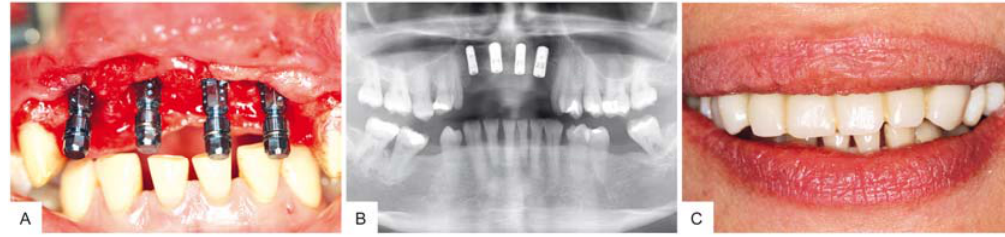
Figure 4. Four implants were placed in locations #7, #8, #9 and #10. ( A ) Buccal view after implant placement; ( B ) Radiograph taken immediate after the procedure; ( C ) Temporary restoration.